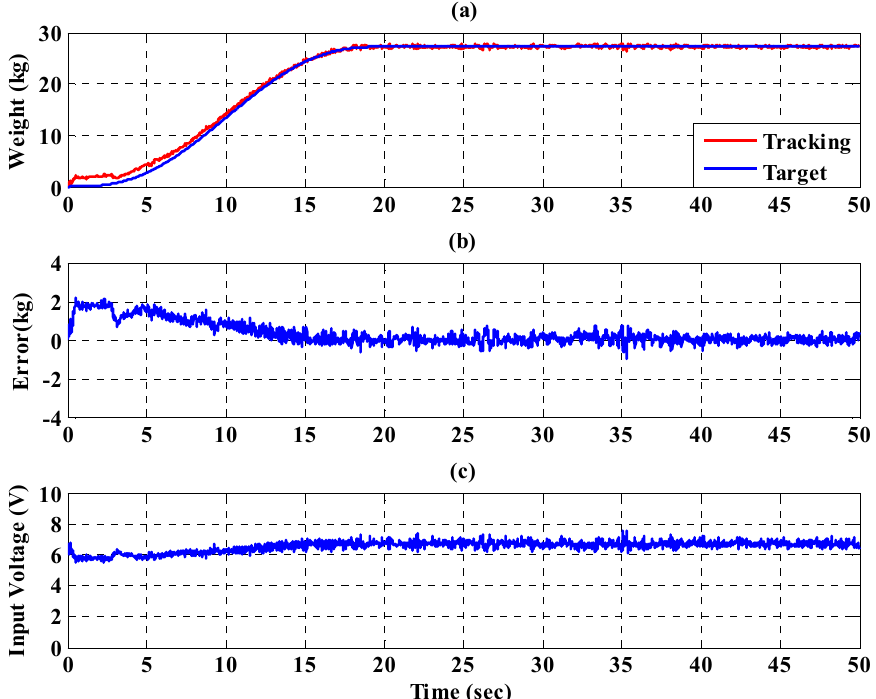
Figure 22. Experimental results for the PBWSS with a static bodyweight unloading force of 40% (27.2 kg) in 50 s. ( a ) Tracking trajectory; ( b ) tracking error; ( c ) control voltage.